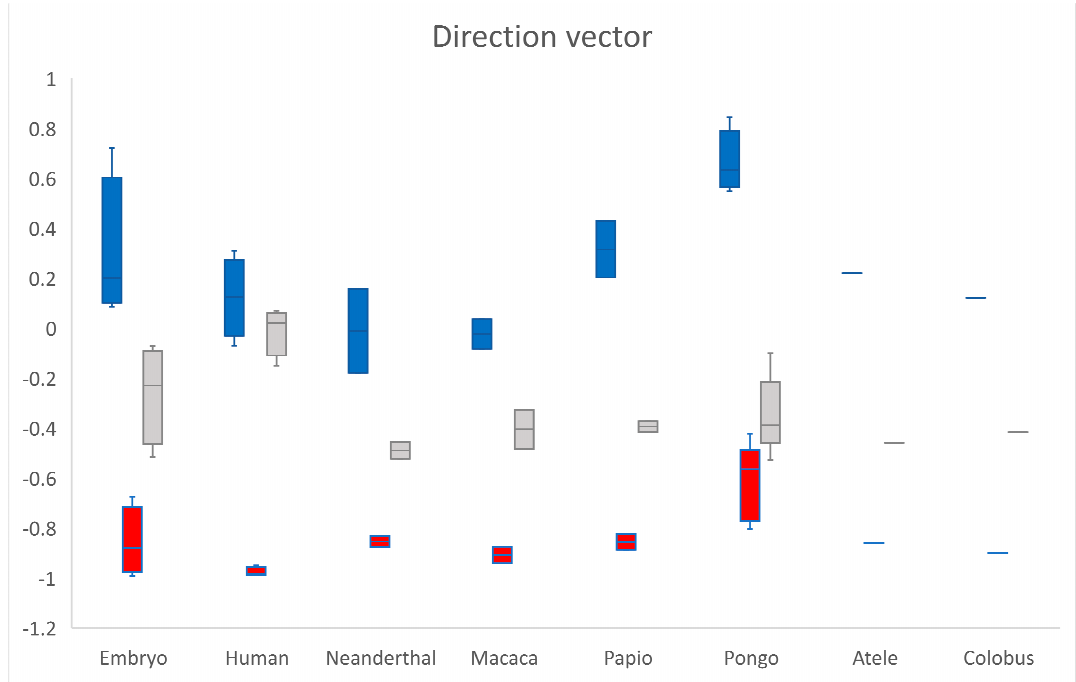
Figure 5. The direction vector from scaphoid centroid towards os centrale centroid is expressed in notation as a combination of three scalar components. cos( 𝑣⃗ , 𝑥⃗ ) in blue, cos( 𝑣⃗ , 𝑦⃗ ) in red and cos( 𝑣⃗ , 𝑧⃗ ) in grey. According to the different axes, the os centrale is always distal (cos( 𝑣⃗ , 𝑦⃗ ) < 0) and most often posterior (cos( 𝑣⃗ , 𝑧⃗ ) < 0) compared to the scaphoid bone.